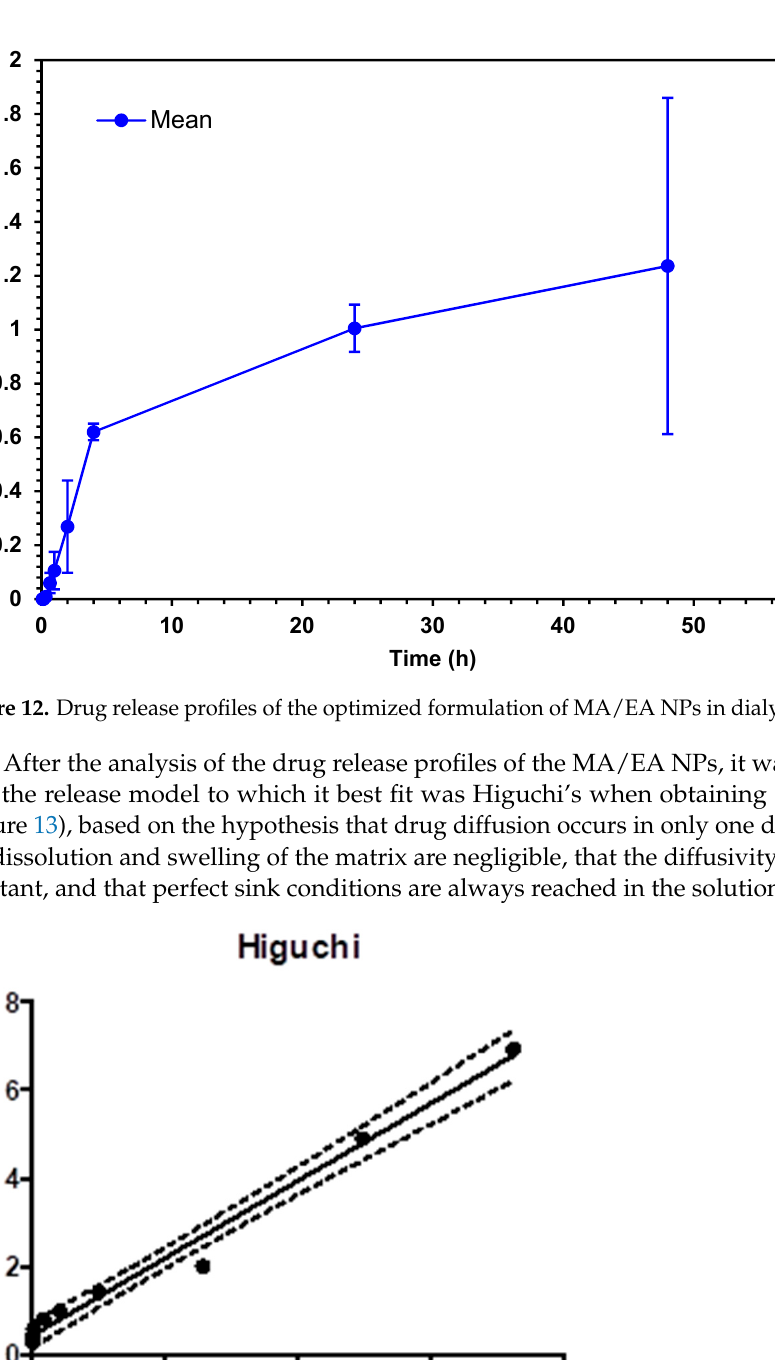
Figure 13. Higuchi model where r 2 = 0.9850.